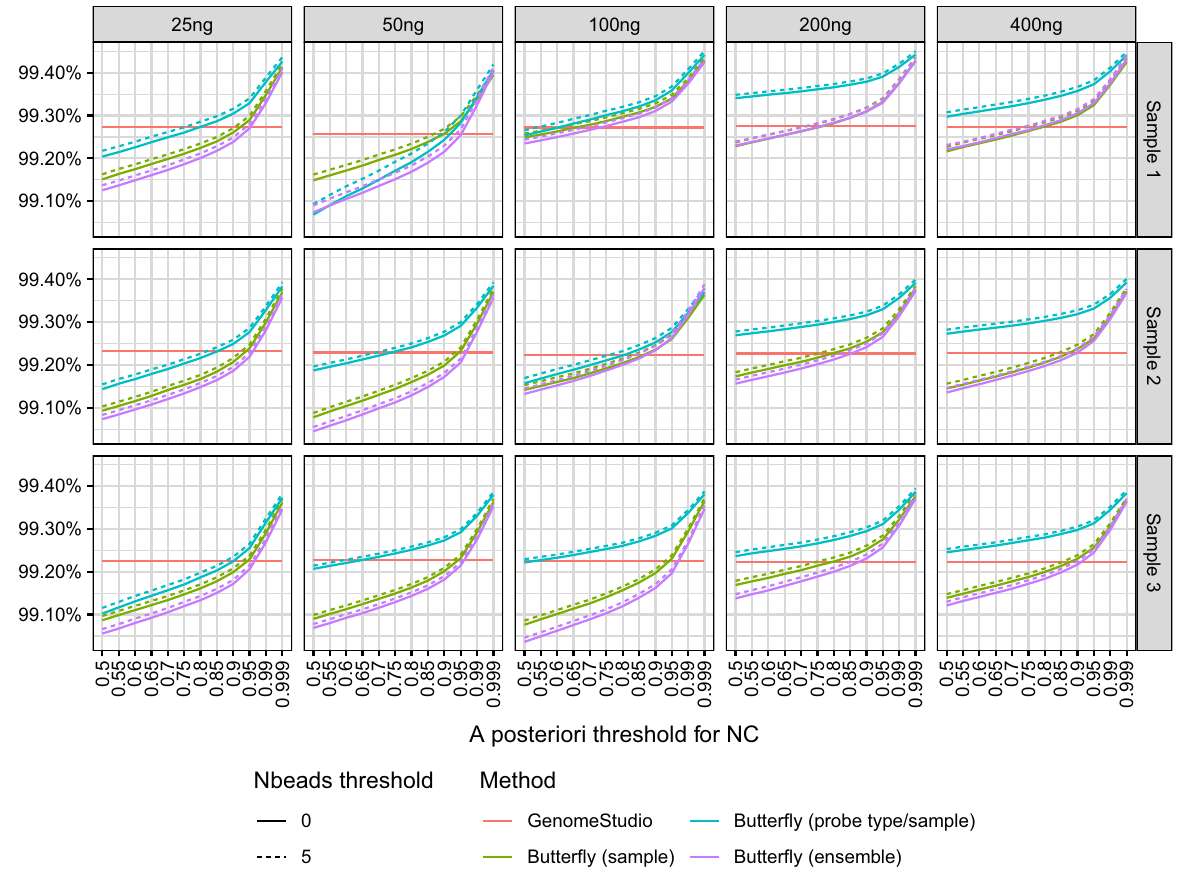
Figure 5. Concordance between SNP calls obtained with WGS, GenomeStudio, and the butterfly method. Only SNPs with SNP calls by all methods were included. The concordances were above 99% for all